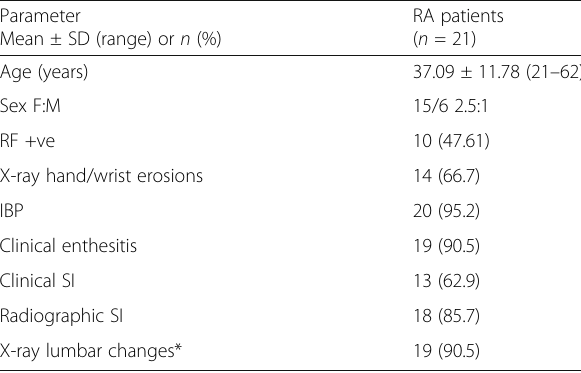
Table 3 Characteristics of HLA-B27 positive patients with RA who met any of the classification criteria for SpA or AS Parameter Mean ± SD (range) or n